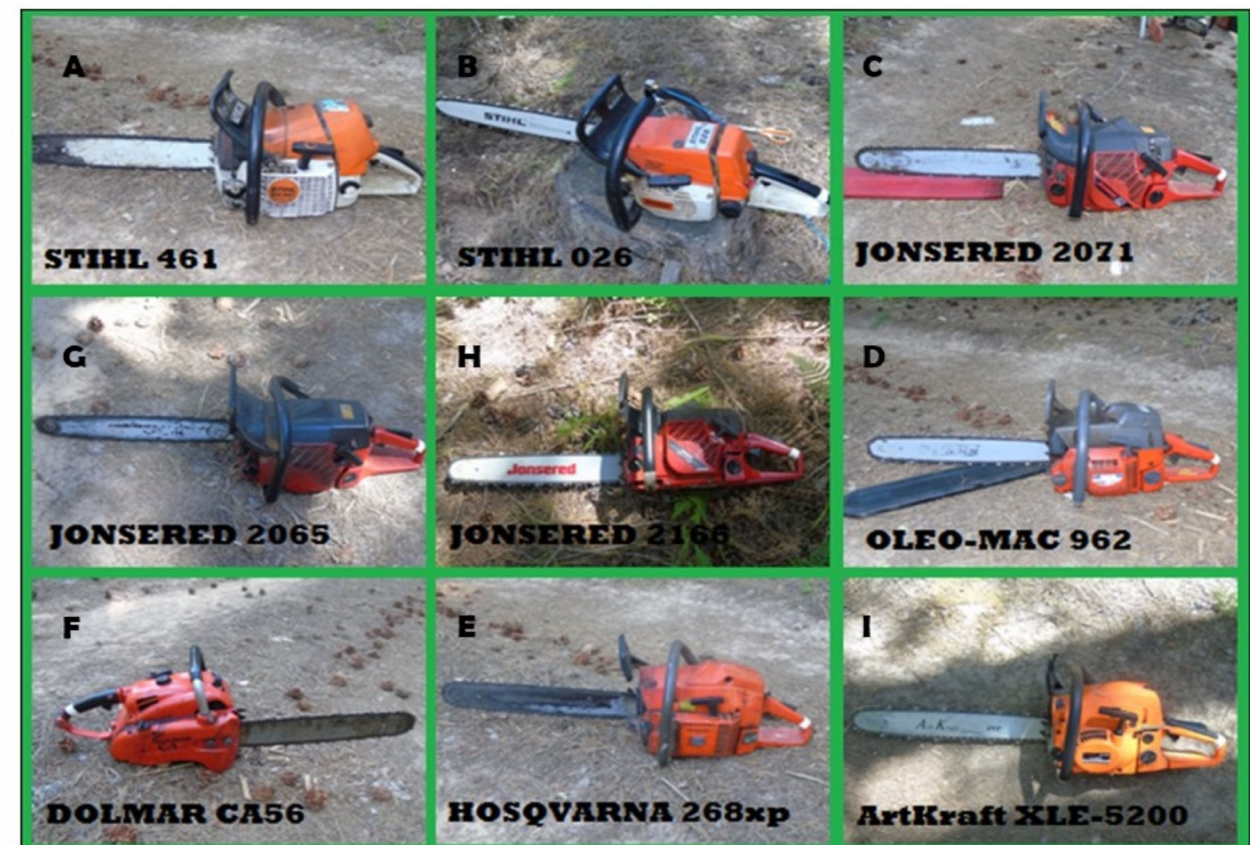
Figure 1. The nine chainsaws analyzed in this work.